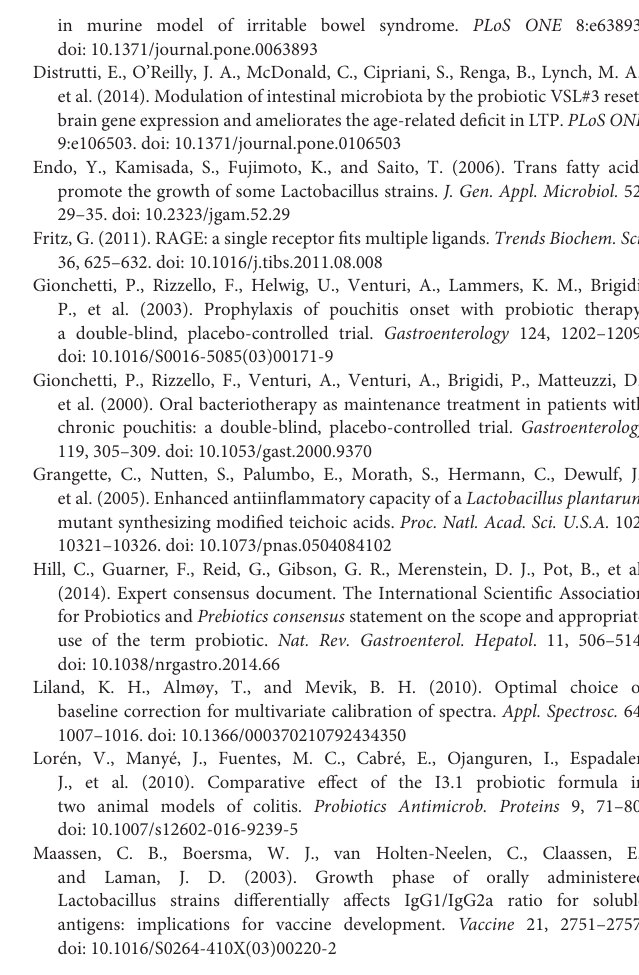
Supplementary Table 1 | Calculation of CDAI (Colitis Disease Activity Index)